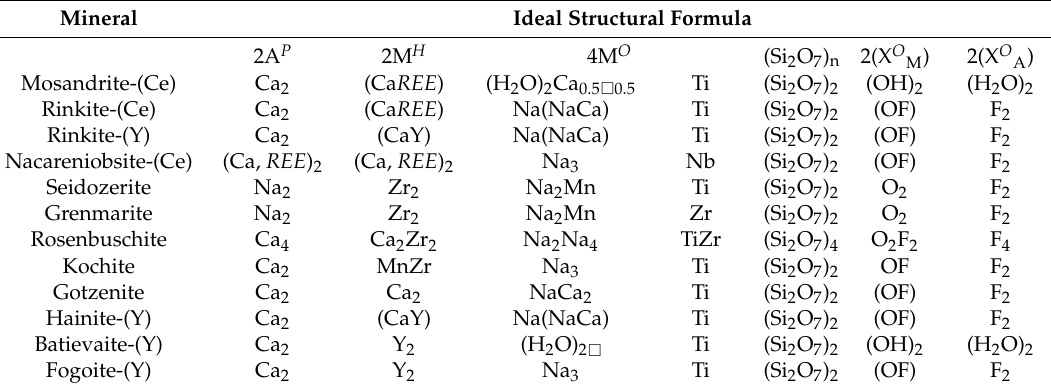
Table 1. Ideal structural formulae for rinkite group